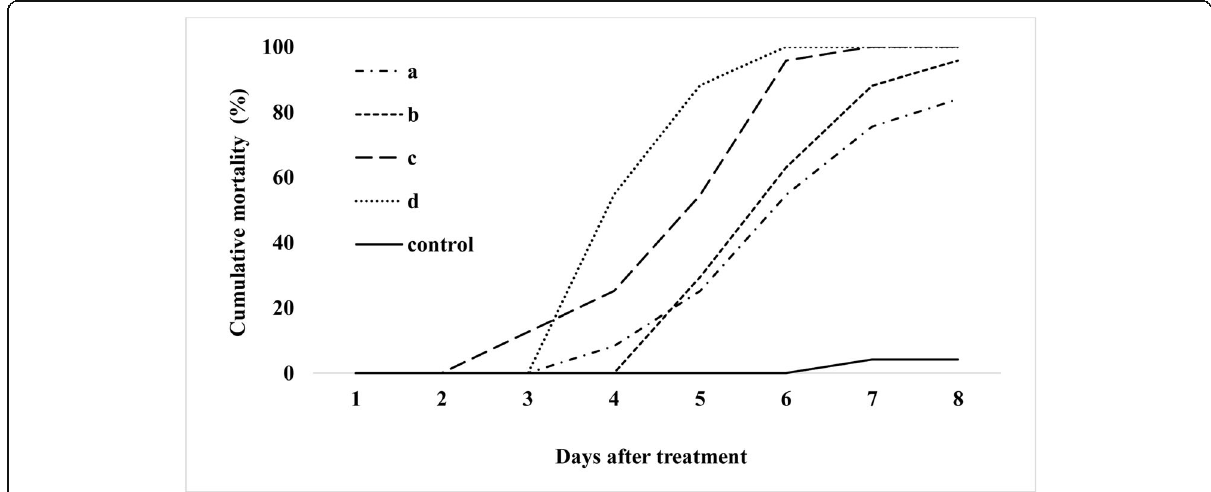
Fig. 2 The efficacy of Beauveria bassiana against Callosobruchus maculatus adults. a 22±1°C, 1×10 6 conidiaml − 1 ; b 26±1°C, 1×10 6 conidiaml − 1 ; c 22±1°C, 1×10 8 conidiaml − 1 ; d 26±1°C, 1×10 8 conidiaml −